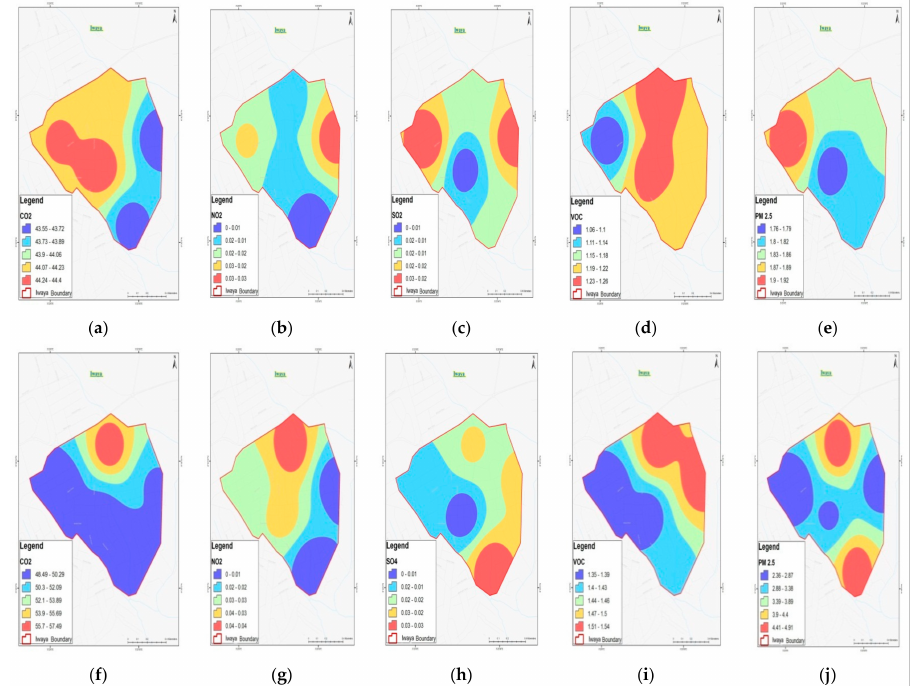
Figure 7. Pattern of air pollutant concentrations from the Iwaya slum settlement from 2018 to 2019 for the wet and dry season sampling periods. The intensity of the pollution is represented by four color types on the map, which depict hot and cold spots. ( a ) CO 2 mg/m 3 Wet; ( b ) NO 2 mg/m 3 Wet; ( c ) SO 2 mg/m 3 Wet; ( d ) VOC mg/m 3 Wet; ( e ) PM 2.5 µ g/m 3 Wet; ( f ) CO 2 mg/m 3 Dry; ( g ) NO 2 mg/m 3 Dry; ( h ) SO 2 mg/m 3 Dry; ( i ) VOC mg/m 3 Dry; ( j ) PM 2.5 µ g/m 3